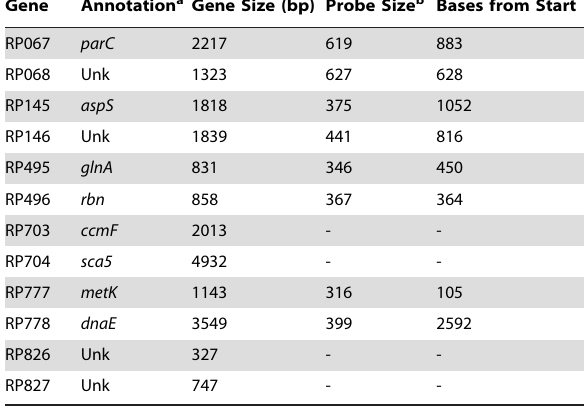
Gene Annotation a Gene Size (bp) Probe Size b Bases from Start